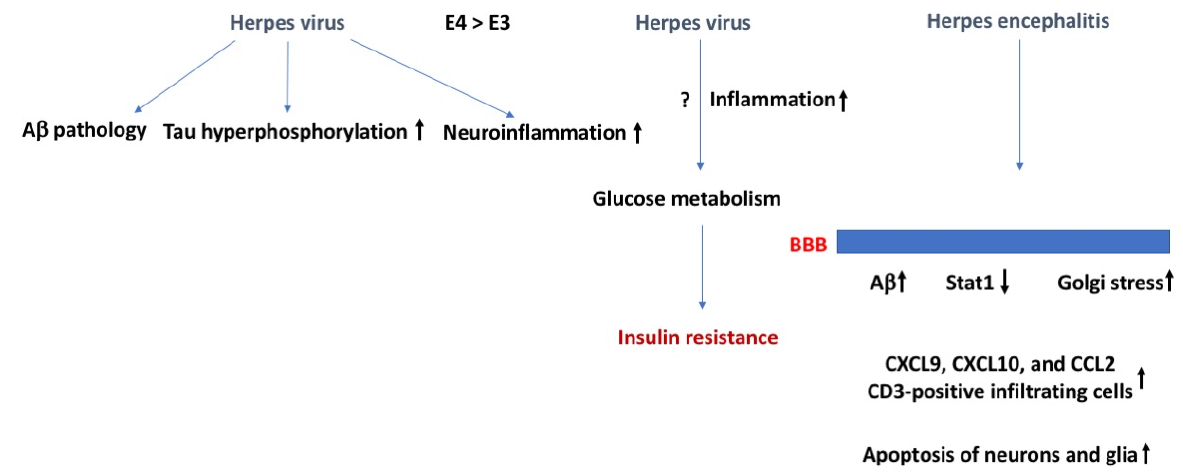
Figure 2. Herpes virus, insulin resistance, and the BBB. Herpes virus can induce AD-related neuropathology, including A β pathology, tau hyperphosphorylation, and neuroinflammation. Herpes virus might negatively affect glucose metabolism and cause insulin resistance because of increased inflammation. As there is more viral replication in E4 than E3 carriers, these effects are expected to be more pronounced in E4 than E3 carriers. In case of Herpes encephalitis, effects on the BBB might result in enhanced A β levels and enhanced Golgi stress and an increase in CD3-positive infiltrating cells and apoptosis of neurons and glia. The arrows in bold indicate the direction of the effects. For more details, see text.